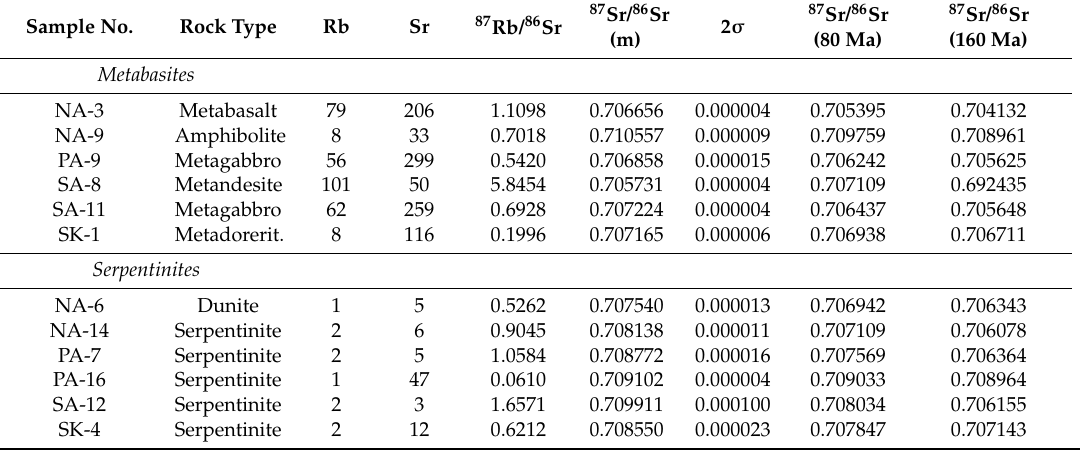
Table 2. Rb-Sr and Sm-Nd isotope data of representative ophiolitic metabasites and serpentinites from the Aegean islands of Paros, Naxos, Samos, and